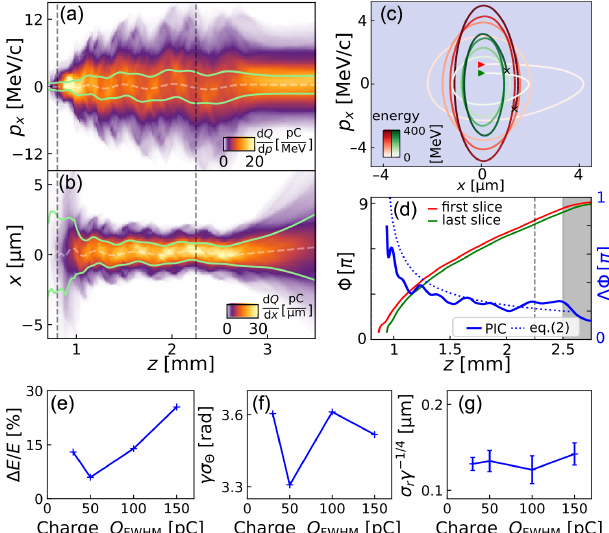
FIG. 6. PIC particle tracking for 50 pC charge, (a) and (b) showcase the evolution of transverse momentum p x and coordinate x , respectively. The green line indicates one standard deviation σ p ð z Þ and σ x ð z Þ . The vertical gray dashed lines indicate the plasma density up- and down-ramp. In (c), the red and green line represent particle orbits in ð x; p x Þ from the earlier and later injected slice in Fig. 4(c). (d) shows the phase ϕ ¼ arctan p x =x γ 1 = 2 of the two orbits from (c). The gray shaded area z > 2 . 5 mm indicates the field-free space outside the plasma accelerator. The thick blue line shows the phase difference Δ ϕ , which indicates a decreasing decoherence during acceleration. The dashed blue line is calculated with Eq. (2) using an averaged γ 0 . The vertical gray dashed line indicates the beginning of the plasma density down-ramp. Close to the end of acceleration ( z ¼ 2 . 0 mm), (e), (f), and (g) present the beam energy band- width Δ E=E , the normalized divergence γσ Θ , and the normalized beam radius σ r γ − 1 = 4 , respectively. Error bars indicate one standard deviation in (g).